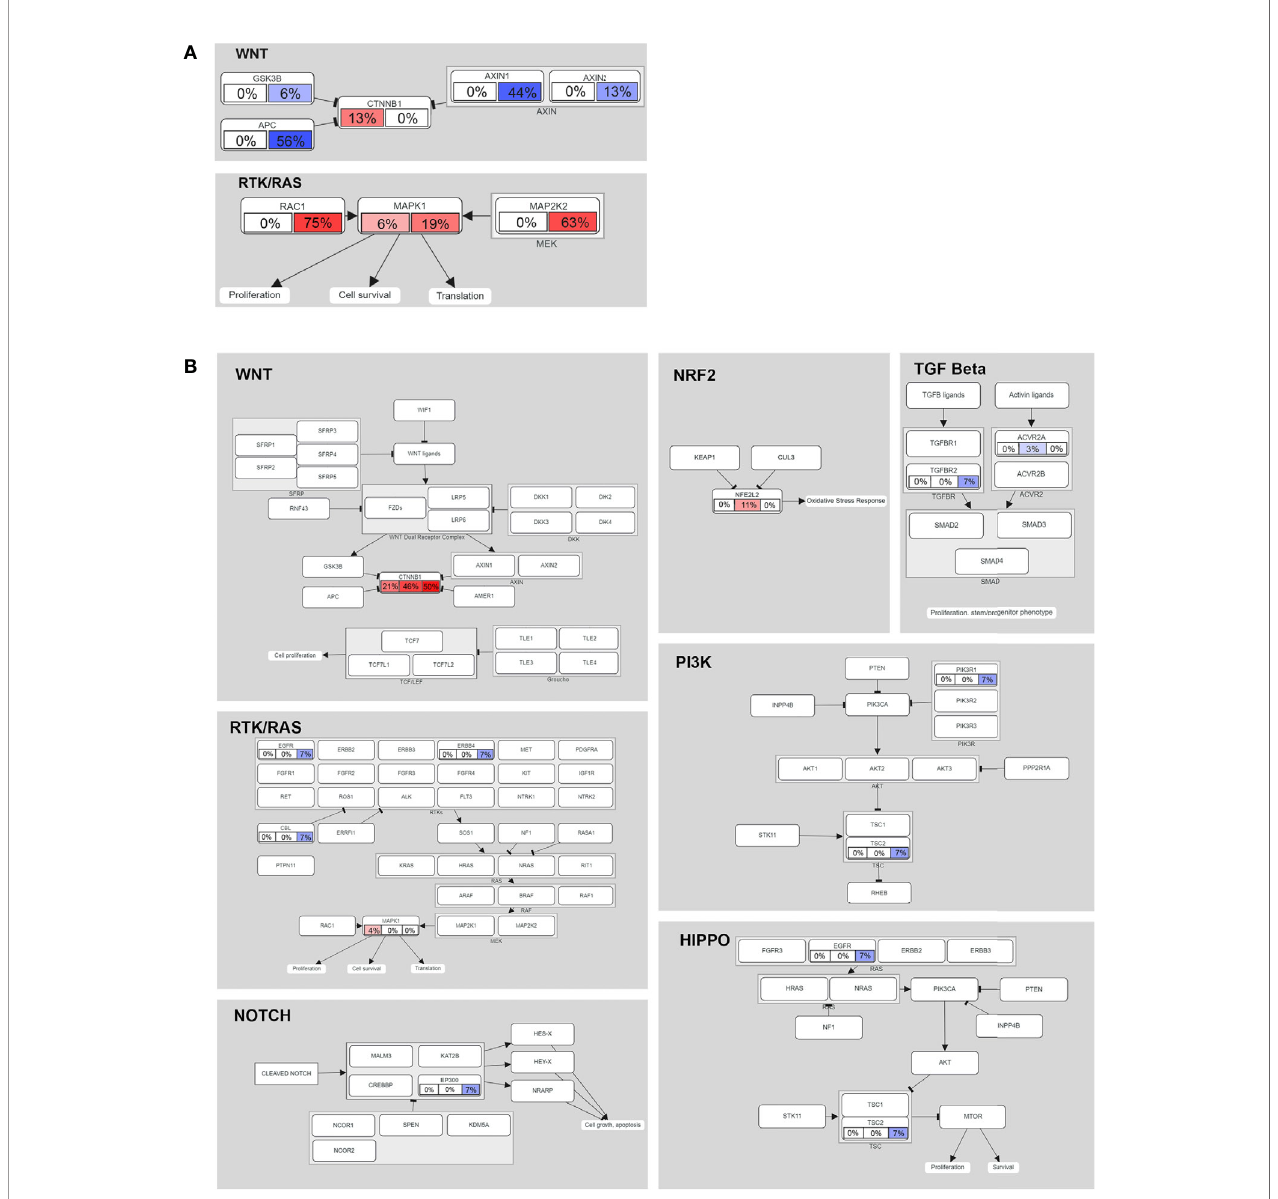
FIGURE 4 | Mutated genes (tumor suppressors indicated in blue, oncogenes indicated in red) and their relationships to other genes, families, complexes, and cellular processes are displayed using curated pathway templates derived from TCGA data. (A) Oncogenic network in HB (16 patients in our center). Percentages of somatic mutations and CNAs shown in the left and right portions of each rectangle. (B) The oncogenic network of somatic mutations in 75 cases of HB. For each gene, the fraction of mutated samples within the Asian, Caucasian and Hispanic populations is